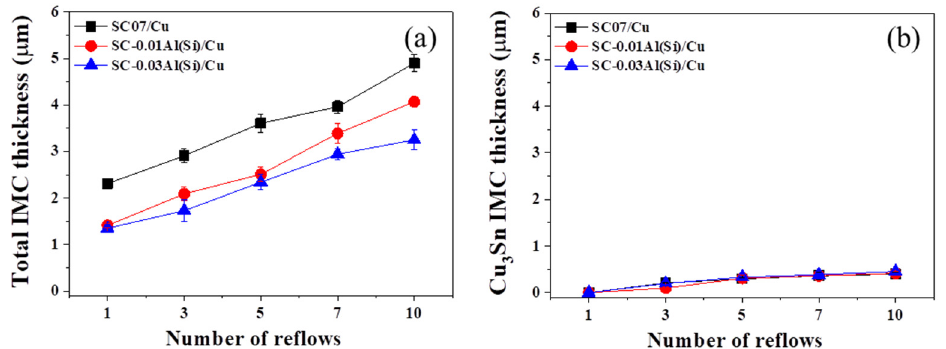
Figure 8. Plots of the IMC thickness versus the number of reflows: ( a ) total IMC thicknesses and ( b ) Cu 3 Sn IMC thicknesses. ( b ) Cu 3 Sn IMC